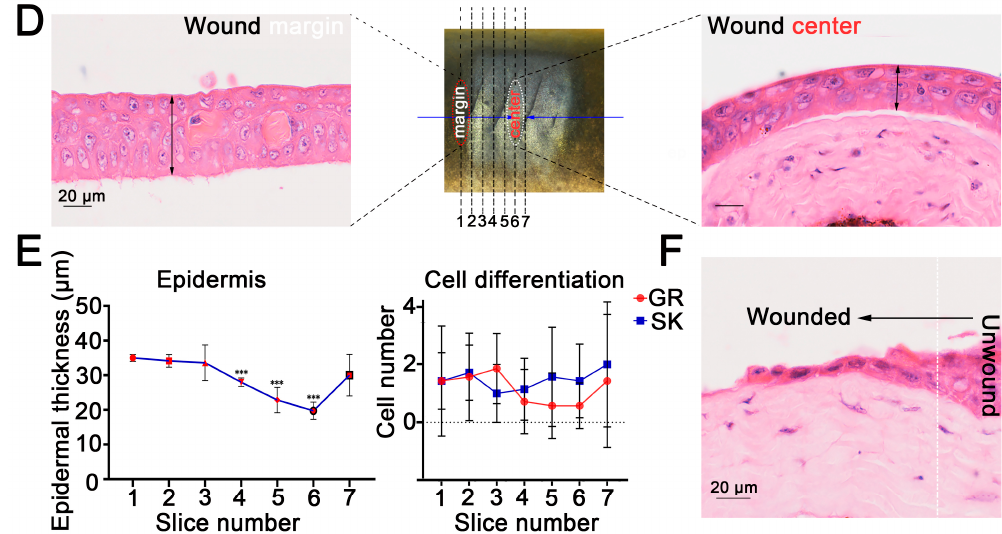
Figure 1. Wound healing process of the damaged lamprey ( Lethenteron reissneri ) epidermis. ( A ) Five time points were selected to characterize the healing process of lamprey. ( B ) Representative images of the skin healing process of adult lamprey after epidermal damage; three wounds on each side are shown (red square). ( C ) Representative images of H&E-stained sections of the wound bed. Significant changes are visible in the subcutaneous fat layer, and massive red blood cell infiltration was detected (black arrow). Scale bars, 20 µ m. ( D ) Serial sections were prepared from the wound edge to the center. ( E ) Statistical analysis of the numbers of granular cells and skein cells (left) and the epidermal thickness of sections 1 to 7. *** p < 0.001 versus slice 1. ( F ) Migration of epidermal basal cells to the wound bed. ep: epidermis; de: dermis; PC: pigment cell; MU: mucous cell; SK: skein cell; GR: granular cell; CU: cuticle.